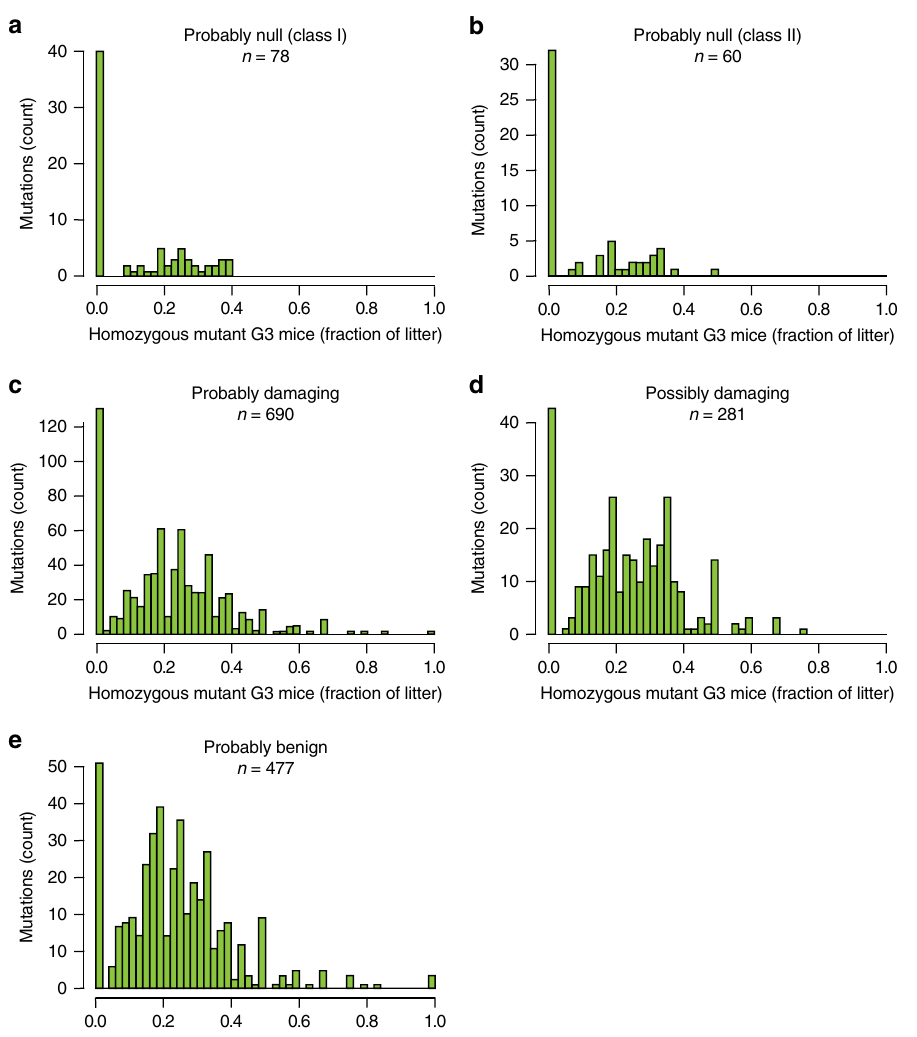
Fig. 2 Distribution of homozygous mutant mouse frequencies among G3 mice produced by heterozygous G1 × heterozygous G2 matings. a – e For mutations of the indicated PP2 categories and putative null mutations, the proportions of homozygous mutant G3 mice resulting from heterozygous G2 matings were